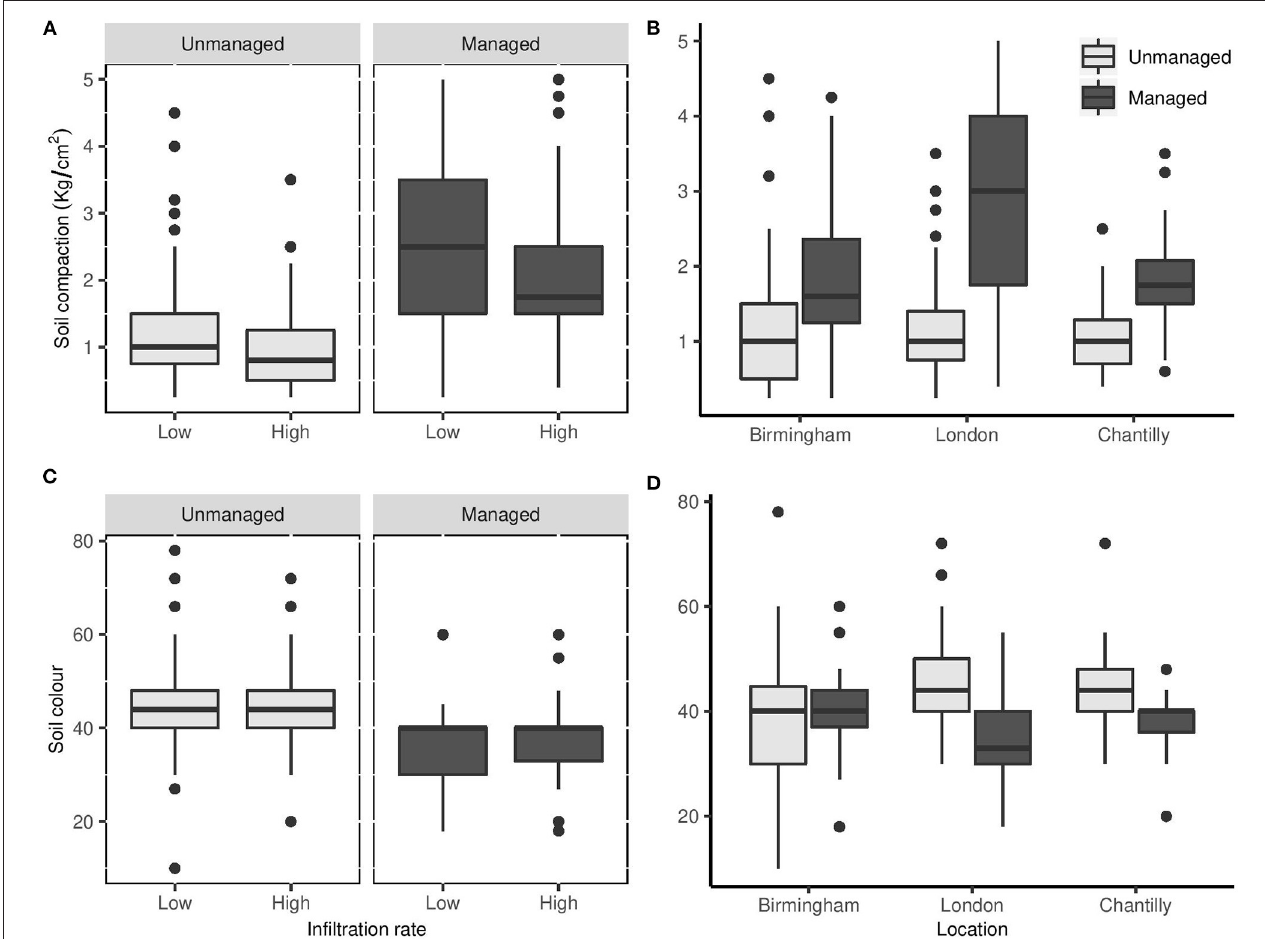
FIGURE 3 | Soil compaction (kg/cm 2 ) according to (A) management type: unmanaged (gray) and managed (black) in relation to infiltration rate categorized (binary) as low ( < 1.75 mL/min), or high ( ≥ 1.75 mL/min), (B) location of the park where sampling took place. Soil color (higher number = darker) in relation to (C) management type: unmanaged (gray) and managed (black) in relation to infiltration rate categorized (binary) as low ( < 1.75 ml/min) or high ( ≥ 1.75 ml/min), (D) location of the park where sampling took place. Boxplots as per Figure 2 .